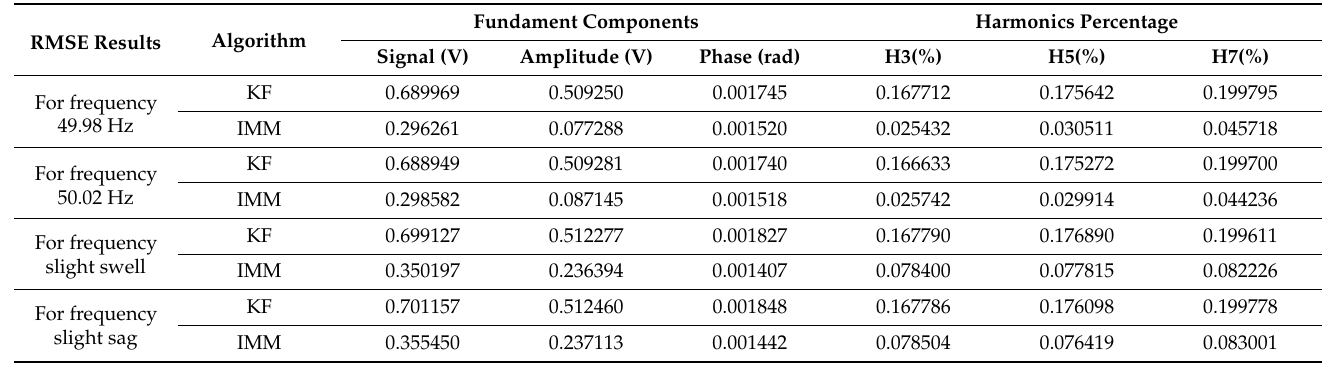
Table 3. Simulation RMSE results for voltage frequency slight fluctuations.